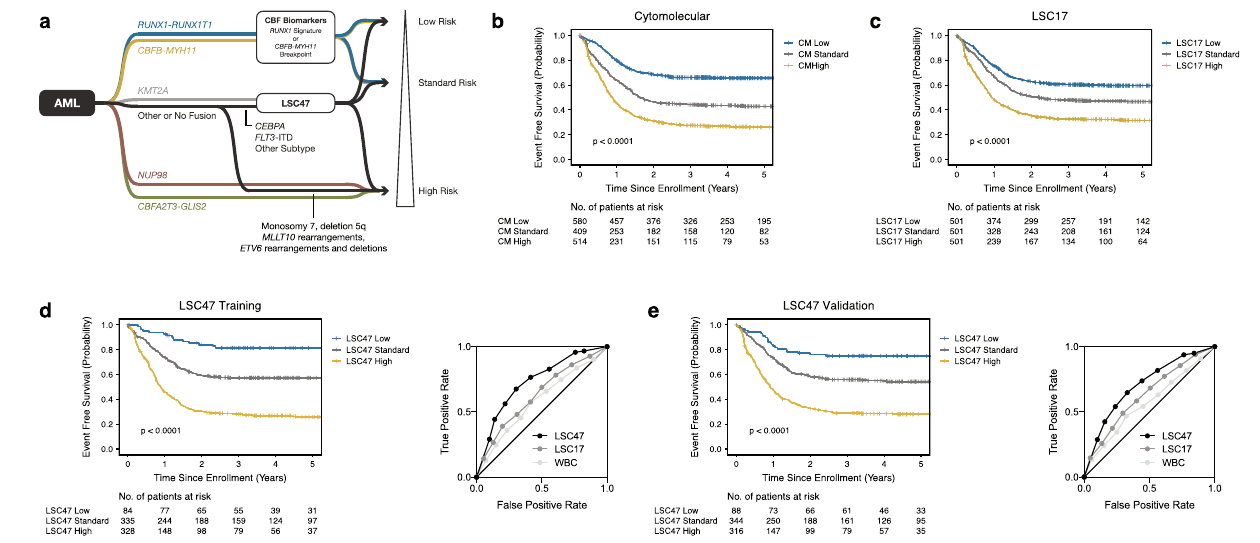
Fig. 5 | LSC47 risk strati fi cation model. a To build a robust risk prediction model for pediatric AML, we aggregated LSC47 based signatures with other validated biomarkers(e.g., RUNX1-RUNX1T1 transcriptionalsignatureand CBFB-MYH11 fusion breakpoint location) within our training cohort. NUP98 partner fusion and CBFA2T3-GLIS2 AMLs are associated with 5-year EFS of < 20% and were therefore